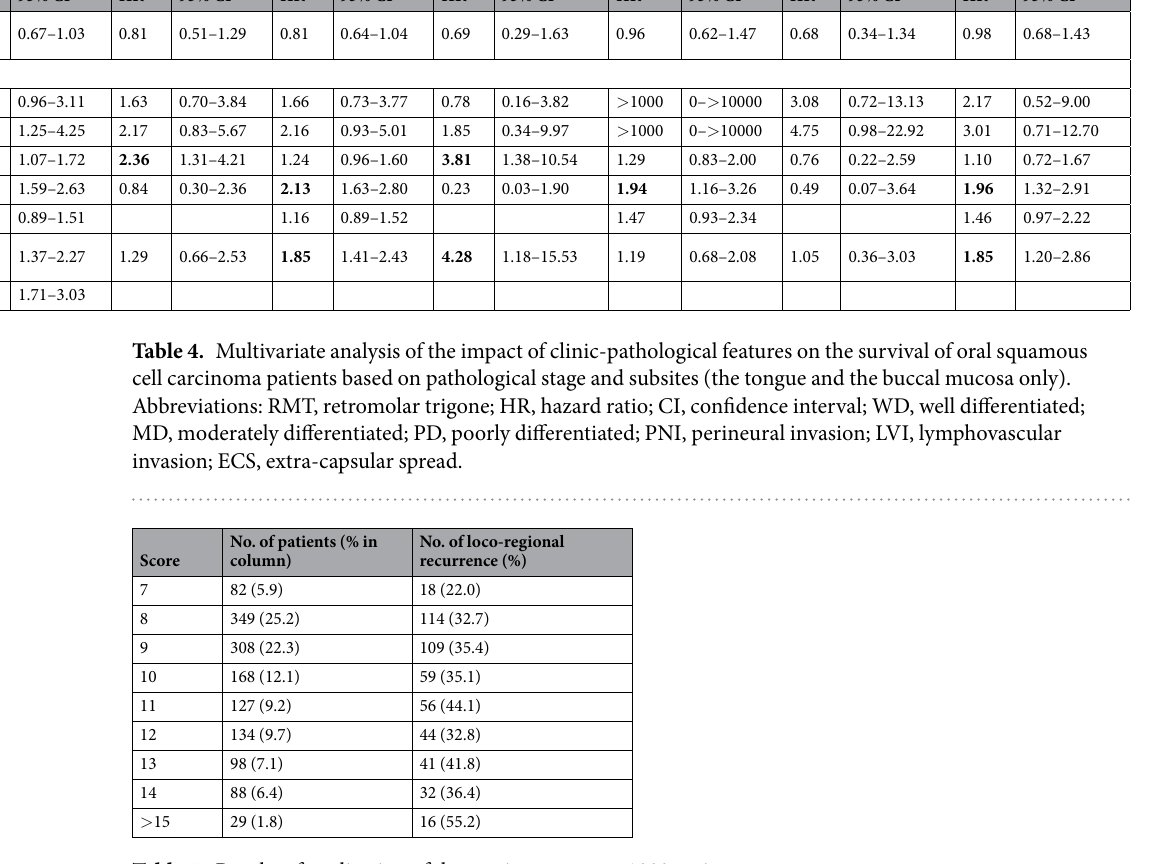
Table 5. Results of application of the scoring system to 1383 patients.